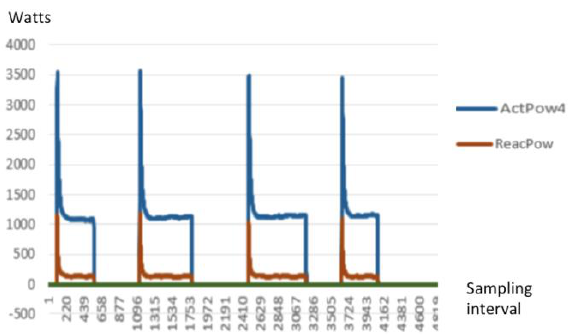
Figure 7. Power (W) signature of a vacuum cleaner.